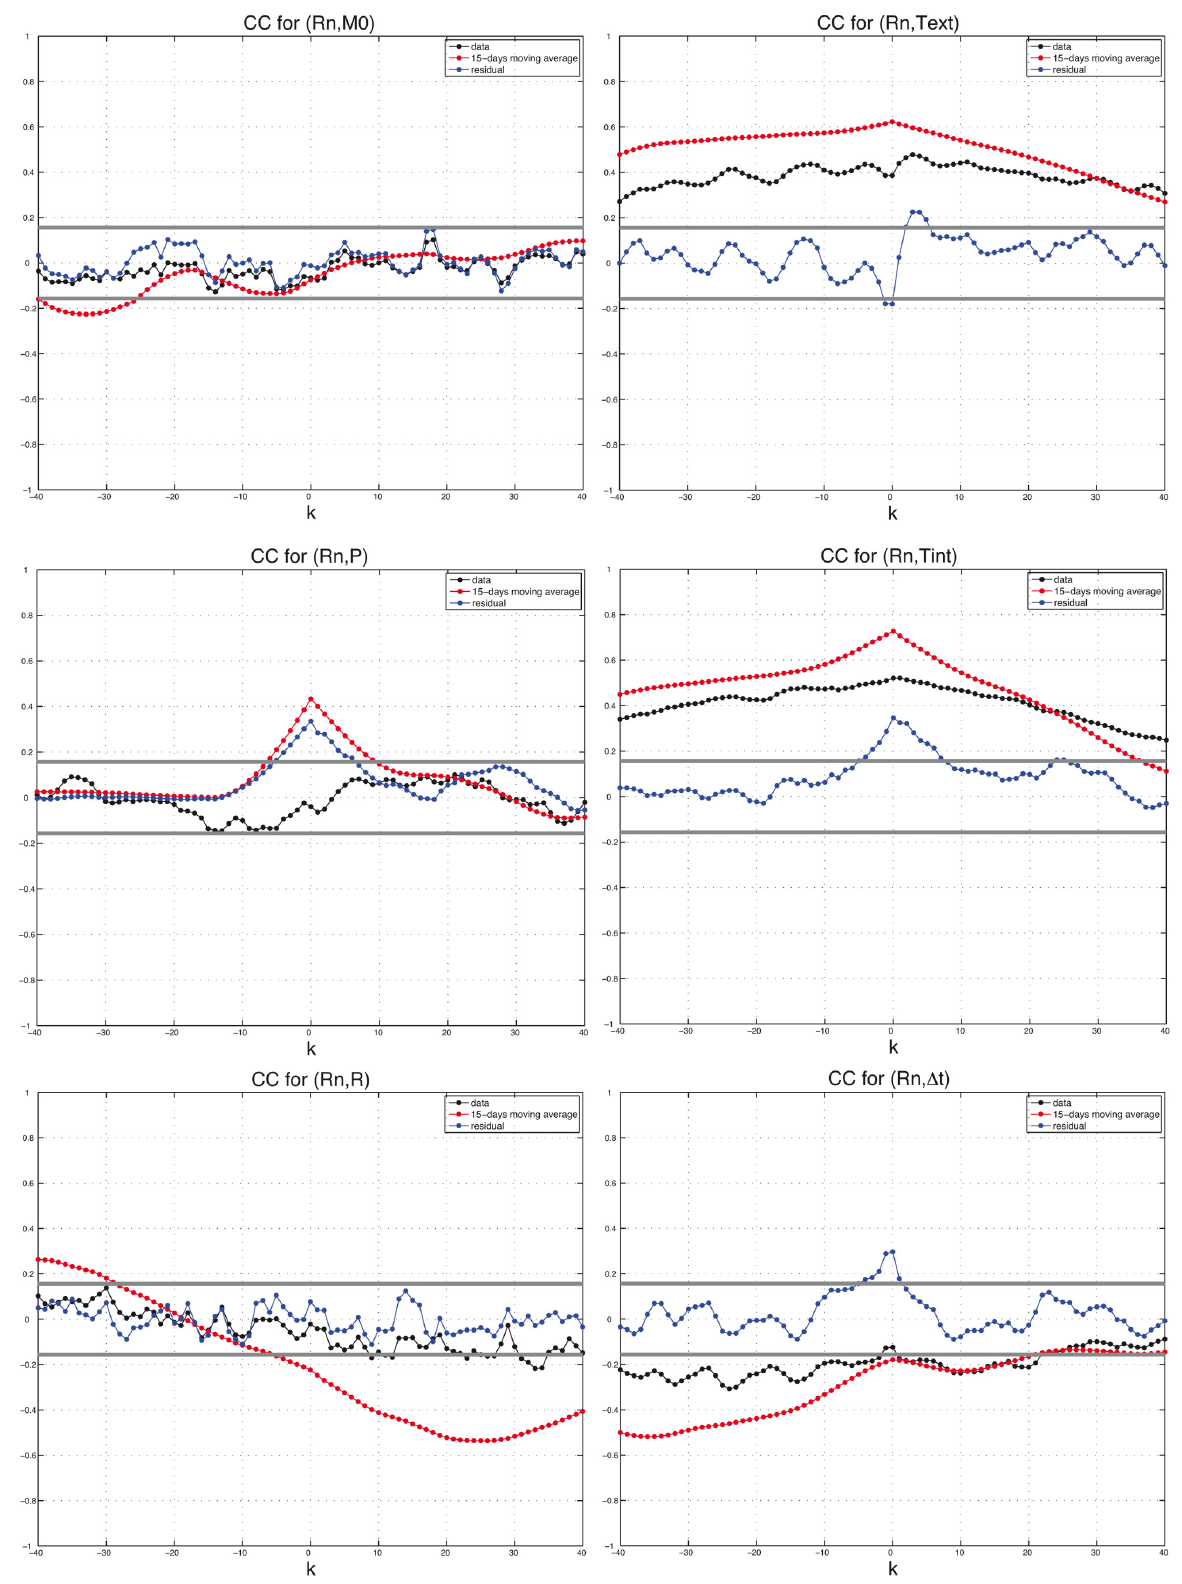
Figure 9. The same as in Figure 8, but for the segment January 1, 2012 - December 31,